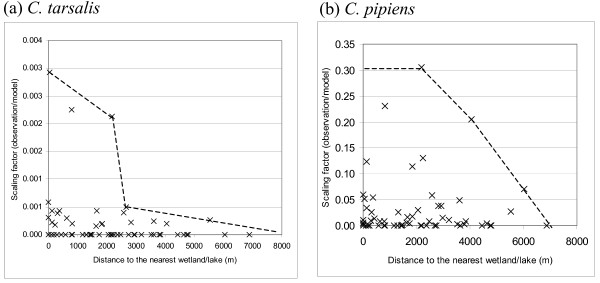
Relation between scaling factor (observation/model) and distance to the nearest wetland/lake. (a) C. tarsalis, (b) C. pipiens Broken lines show relation used in the model. The outlier specified in Figure 4 is not presented.